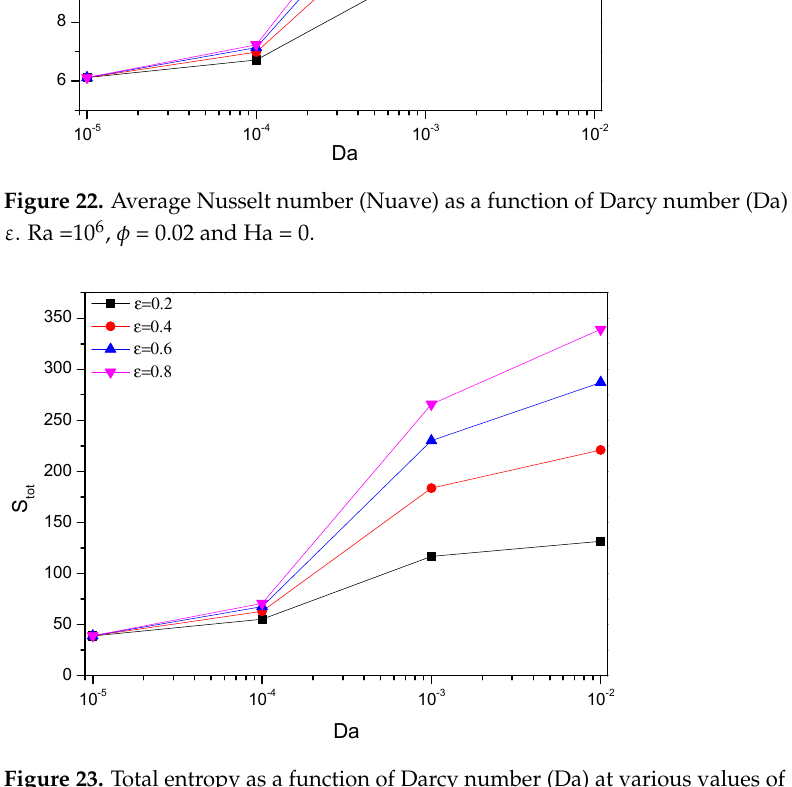
Figure 23. Total entropy as a function of Darcy number (Da) at various values of ε. Ra = 10 6 , 𝜙 = 0.02 and Ha = 0.